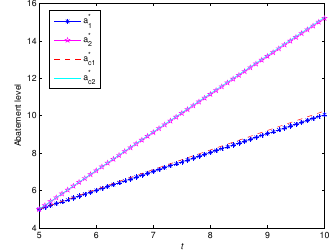
Figure 3. The abatement levels of the noncooperative transboundary pollution problems in Wanzhou District, Kaizhou District and Yunyang County.